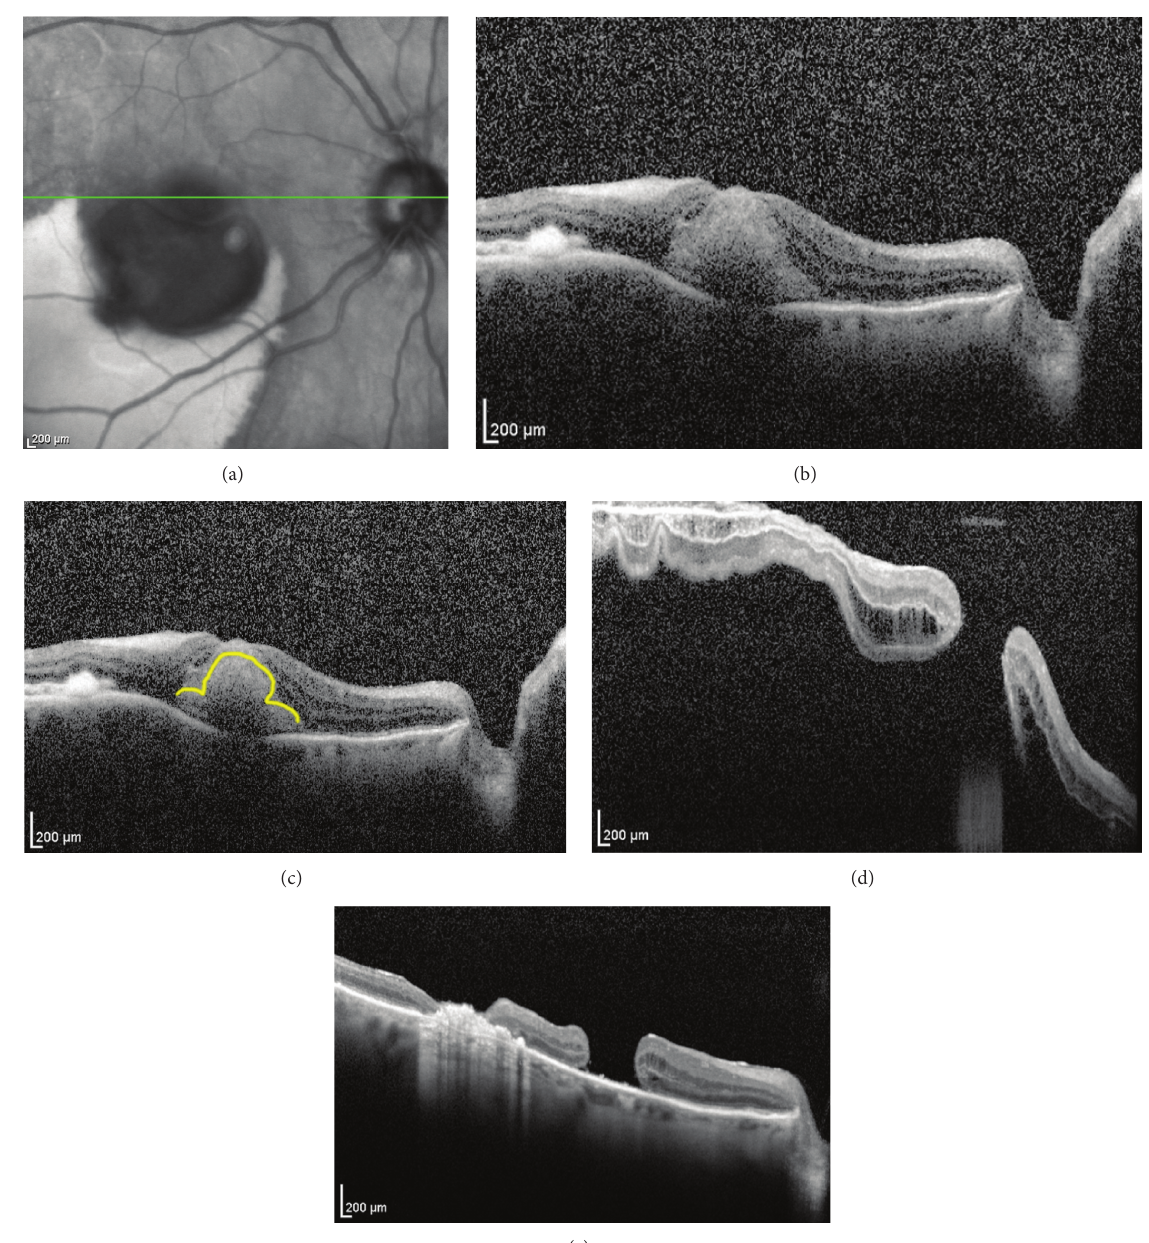
Figure 1: (a) Infrared reference image and (b) foveal spectral domain optical coherence tomography (SDOCT) raster scan of the right macula. (c) Subretinal hemorrhage displaced outer retinal tissue laterally to produce an “ omega-” shaped contour for the outer retina superimposed as yellow on same SDOCT raster scan. (d) Foveal SDOCT raster scan after PPV with subretinal tissue plasminogen activator and ILM peeling that included the fovea, which had resulted postoperatively in macular hole with serous and rhegmatogenous retinal detachment that failed to clear spontaneously. (e) Foveal SDOCT raster scan five months postoperatively demonstrates persistent macular hole and temporal sealed retinotomy with underlying subretinal hyperreflective material and transmission due to retinal